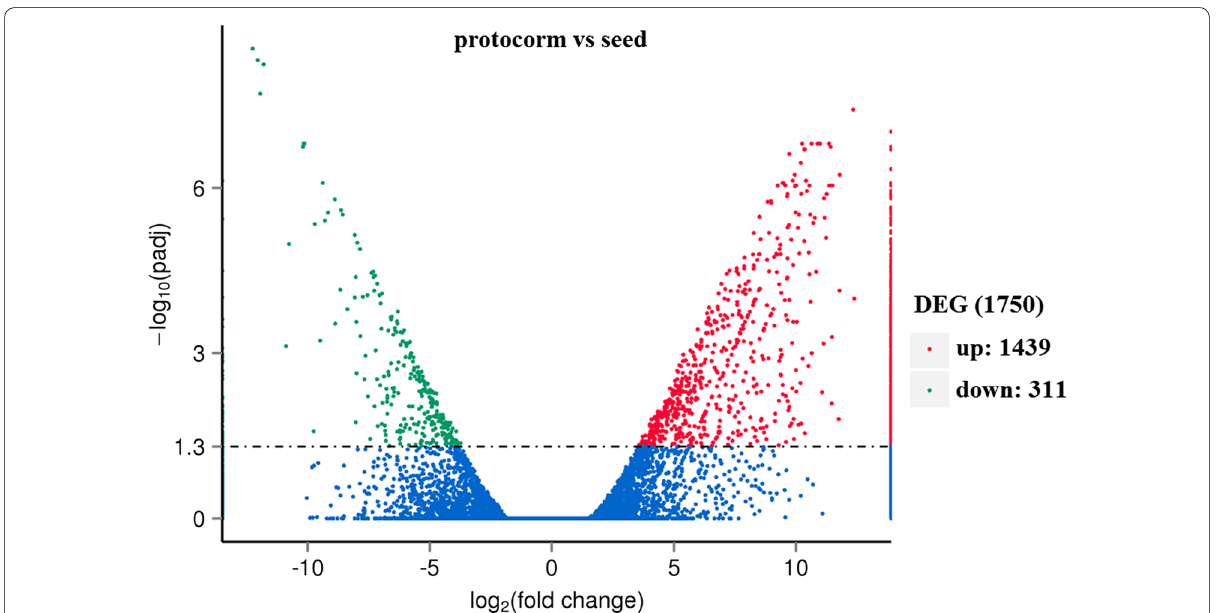
Fig. 2 Volcano plots of differently expressed